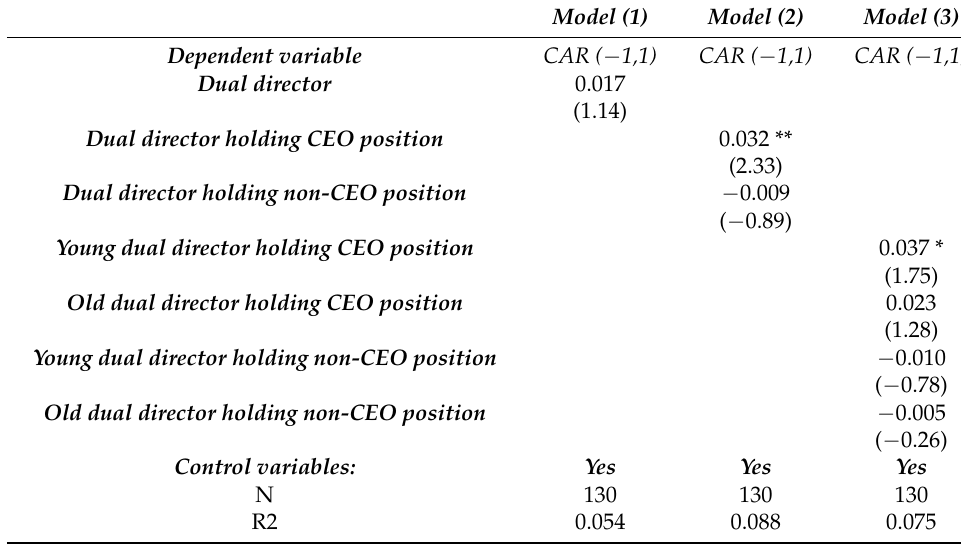
Table A3. Cross-sectional regressions of announcement period CAR. The dependent variable in all regressions is the three-day CAR surrounding the announcement day of the equity carve-out. z-statistics computed using heteroskedasticity-consistent standard errors (clustered by industry) are in parentheses. *, and ** indicate significance at the 10% and 5% levels, respectively .